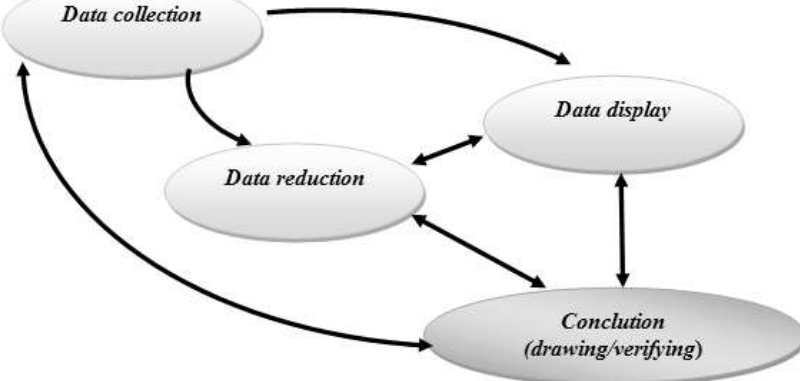
Figure. 1 Interactive Data Analysis